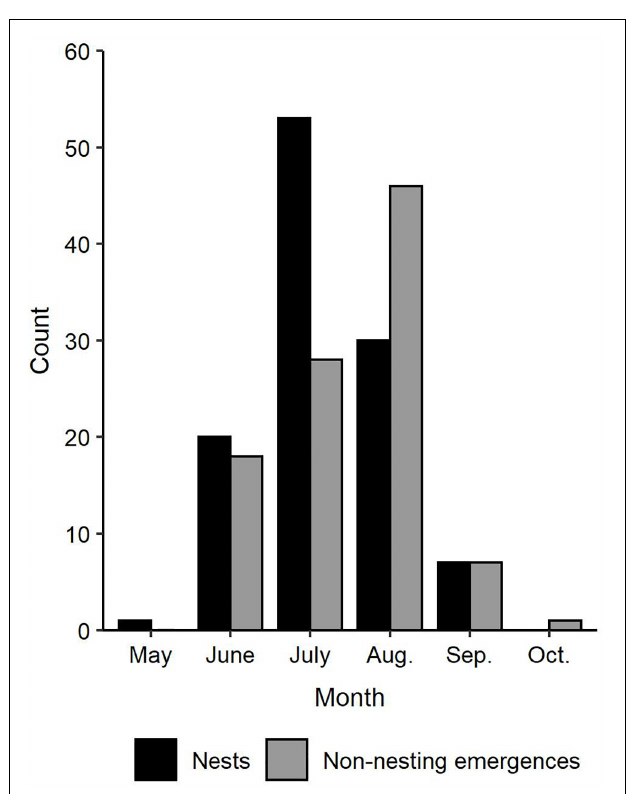
FIGURE 3 | Monthly trends in total number of green turtle ( Chelonia mydas ) nesting activity (nests and non-nesting emergences) documented in Texas from 1987 to